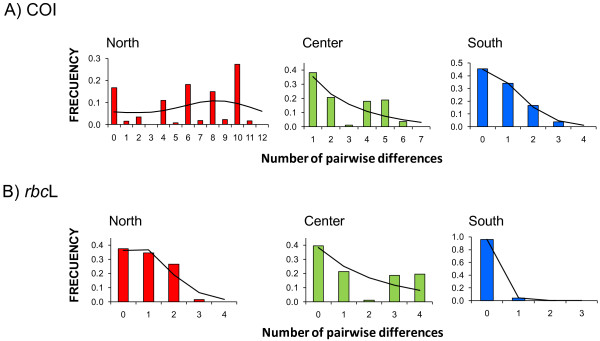
Mismatch distributions of COI and rbcL data for each haplogroup of M. laminarioides . Observed distributions (colored histograms) and expected distributions under a model of pure demographic expansion (black lines) of the number of pair base differences between sequences of COI (A) and rbcL (B) for the Northern, Center and Southern haplogroups.